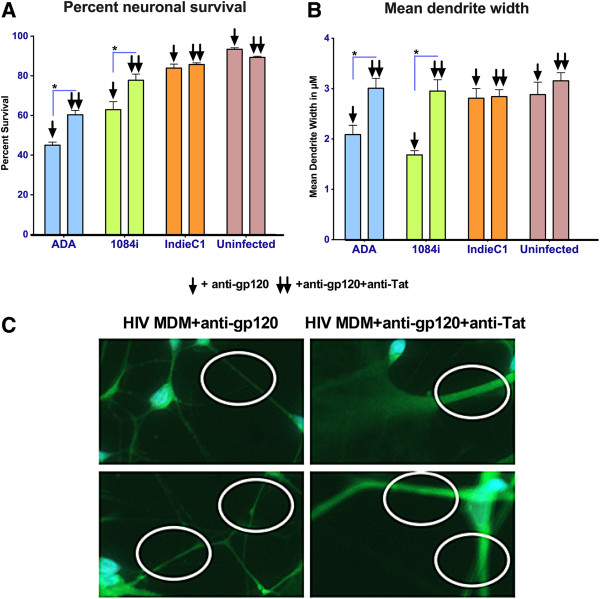
Neurotoxicity of Tat in HIV-1C1084i-infected MDM supernatant. A. HIV-infected media used in Figure 5 were used to pre-adsorb HIV particles and/or free gp120 to eliminate confounding factors and the Tat protein from such media were further adsorbed using anti-Tat antibodies to demonstrate the neurotoxicity specifically due to Tat from HIV − 1BADA and HIV-1C1084i but not HIV-1CIndieC1. For both panels A and B, bars corresponding to medium depleted of virus/gp120 is shown by ↓, whereas those corresponding to medium depleted of both virus/gp120 and Tat protein are shown by ↓↓. B. Measurement of dendritic width shows HIV-1BADA & HIV-1C1084i cause significant decreases in dendritic width. Use of virus-adsorbed medium and virus- plus Tat-adsorbed HIV-1BADA and HIV-1C1084i-infected medium as in Panel A above lead to increase in dendrite width, but not in HIV-1CIndieC-infected medium, clearly demonstrating the role played by HIV-1C1084i Tat in neuronal atrophy. C. Representative fields showing effect of Tat immune-depletion in HIV-1C1084i MDM media on dendrite width. The left top and bottom panels show representative fields of primary neurons treated with HIV-1C1084i MDM media prior to Tat immuno-depletion and the right top and bottom panels show increase in dendrite width following immune-depletion of Tat. * p < 0.05.